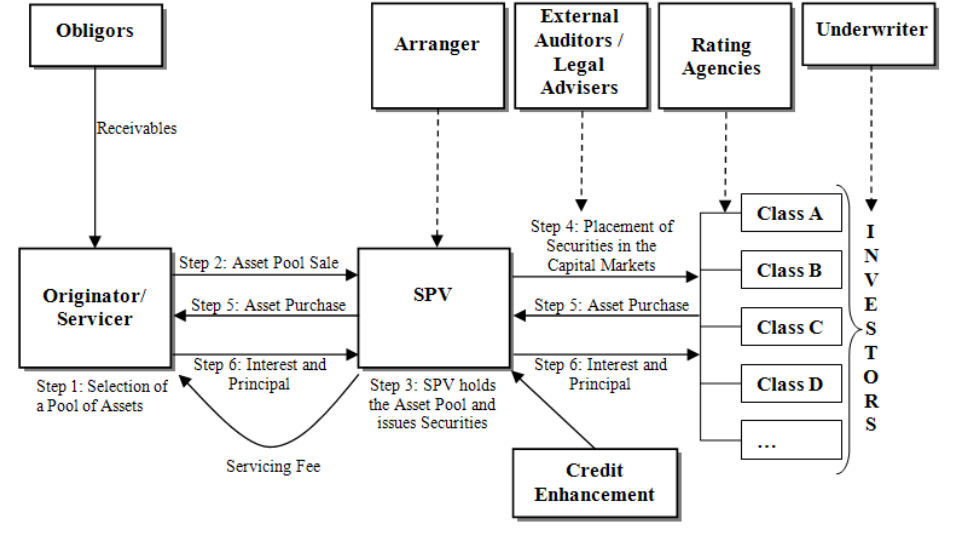
Fig. 2. Basic securitization